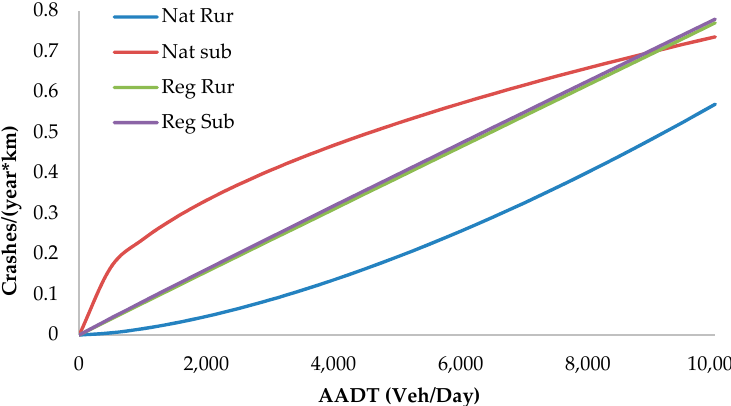
Figure 3. SPF diagram for segments in different road locations and road categories, with CCR equal to zero (tangent).